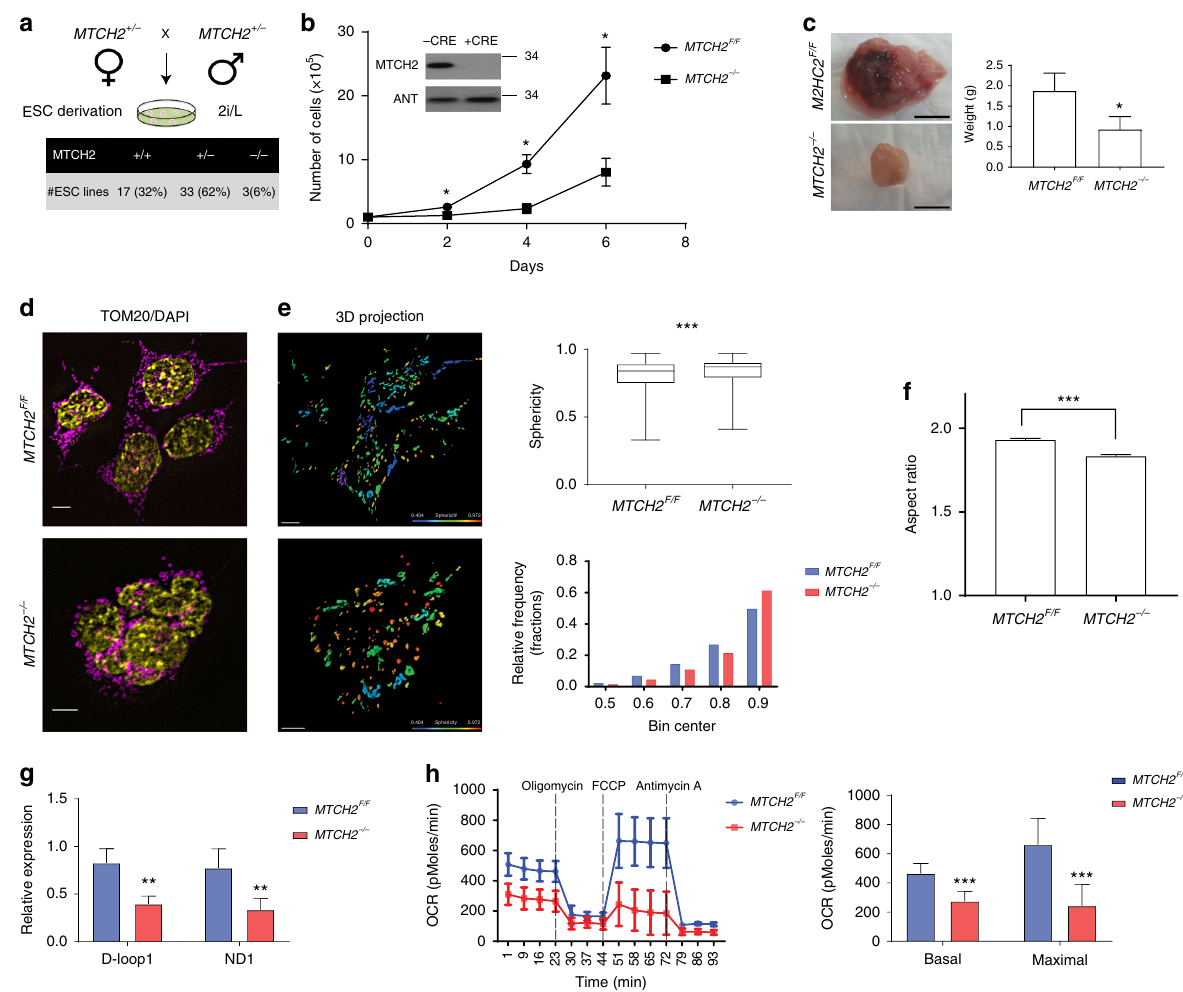
Fig. 2 MTCH2 loss in ESCs results in mitochondrial fragmentation. a Blastocysts grown in 2i/L yielded MTCH2 − / − ESCs at a ratio that is lower than the expected. Percentages of ESCs derivation ef fi ciency after mating of MTCH2 heterozygous mice are presented. b Loss of MTCH2 in naïve ESCs results in slower cell growth. MTCH2 F/F and MTCH2 − / − ESCs growth curve. Results are presented as mean ± SD (* p o 0.05; n = 4). Inset: Immunoblot results of MTCH2 using anti-MTCH2 Abs of MTCH2 F/F ESCs either left untreated ( − CRE) or treated with Cre recombinant in vitro ( + CRE). Mitochondrial adenine nucleotide translocator (ANT) serves as a loading control. c Teratomas obtained from the MTCH2 − / − ESCs in vivo are smaller in size. Representative images are shown (scale bar, 1 cm). Results are presented as mean ± SEM (* p o 0.05; n = 4). Scale bar, 1 cm. d Loss of MTCH2 results in a less- elongated/round mitochondria morphology. Representative IF images (magenta, anti-TOM20 Abs; yellow, DAPI; Scale bar, 5 μ M). e Loss of MTCH2 results in a hyper-spherical mitochondria morphology. Left panels: 3D mitochondria reconstruction of MTCH2 F/F (upper panel) and MTCH2 − / − (bottom panel) ESCs. Scale bar, 5 μ M; Sphericity heat map, 0.404 – 0.972. Top right panel: Box and whiskers plot showing sphericity analysis of 3D reconstructed mitochondria. Results are presented as minimum, lower quartile, median, upper quartile, and maximum values ( ***p o 0.001; n 4 60 cells were scored in three independent experiments)). Bottom right panel: Histogram representation of frequency distribution of the sphericity values of mitochondria. f Loss of MTCH2 resulted in a hyper-fragmented mitochondria morphology. Aspect ratio calculations of MTCH2 F/F and MTCH2 − / − mitochondria are presented. Results are presented as mean ± SEM ( ***p o 0.001; n 4 60 cells were scored in three independent experiments). g Loss of MTCH2 in ESCs results in a decrease in mtDNA copy number. qPCR results of MTCH2 F/F and MTCH2 − / − ESCs mtDNA copy number are presented. Results are presented as mean